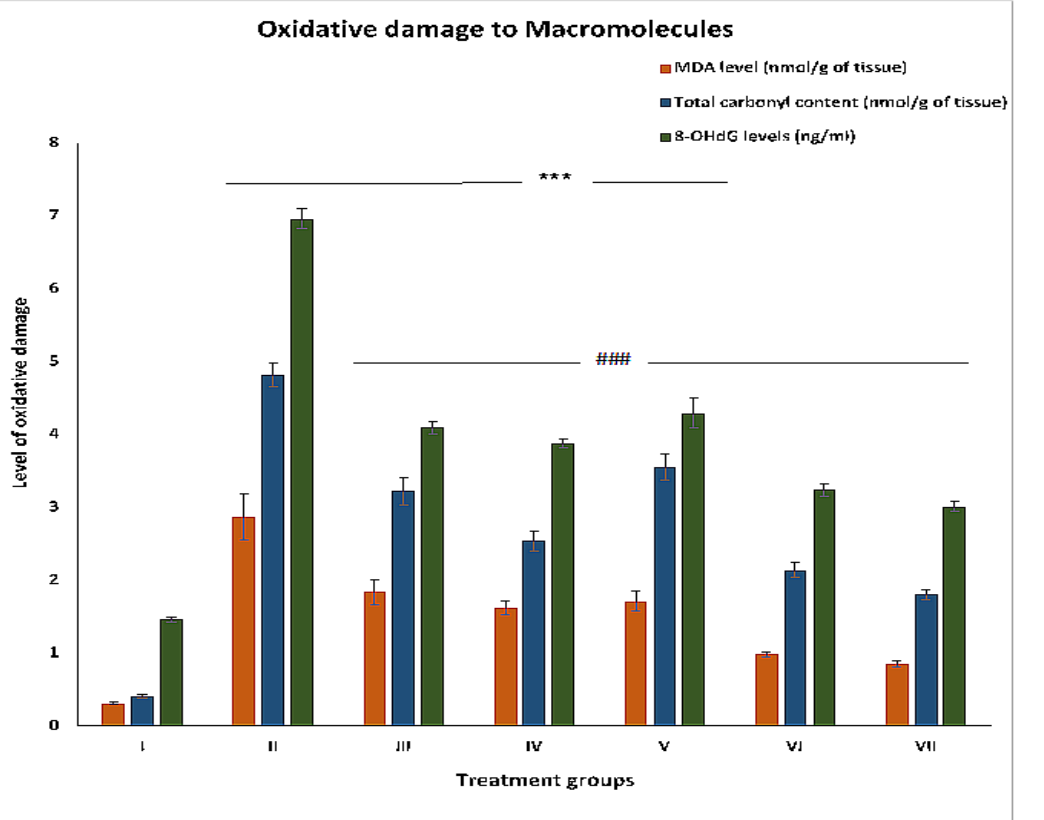
Figure 3. Level of the products of oxidative damage to macromolecules (malondialdehyde; MDA, carbonyl content, 8-hydroxy-2’-deoxyguanosine;8-OHdG) expressed in the indicated units in parentheses in the liver samples. The asterisk mark * indicates values significantly different from the control (group I), while # indicates values significantly different from the control positive (group II). All experiments were conducted in triplicate, and the data are presented as the mean ± SEM. p -values were calculated by Student’s t-test, *** or ### p < 0.001.